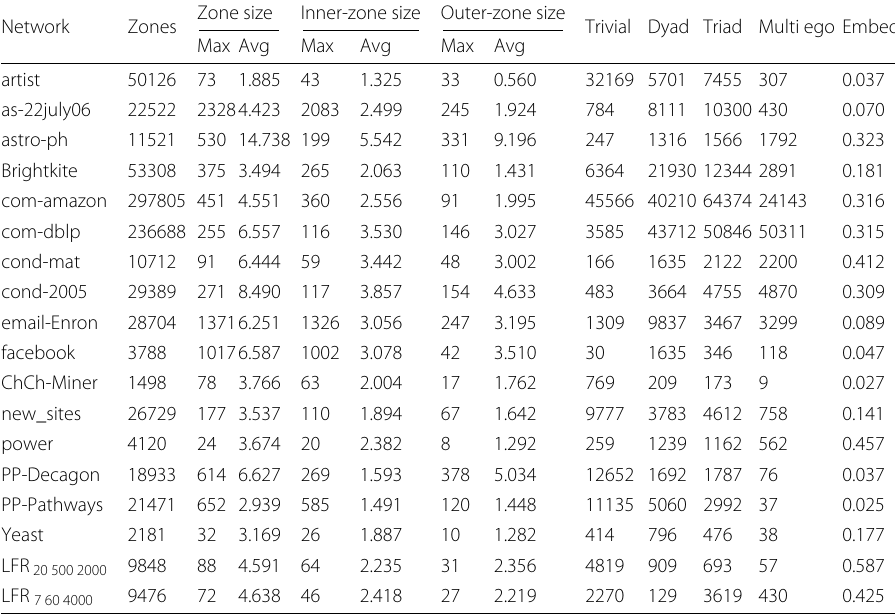
Table 13 Zone properties in real-world